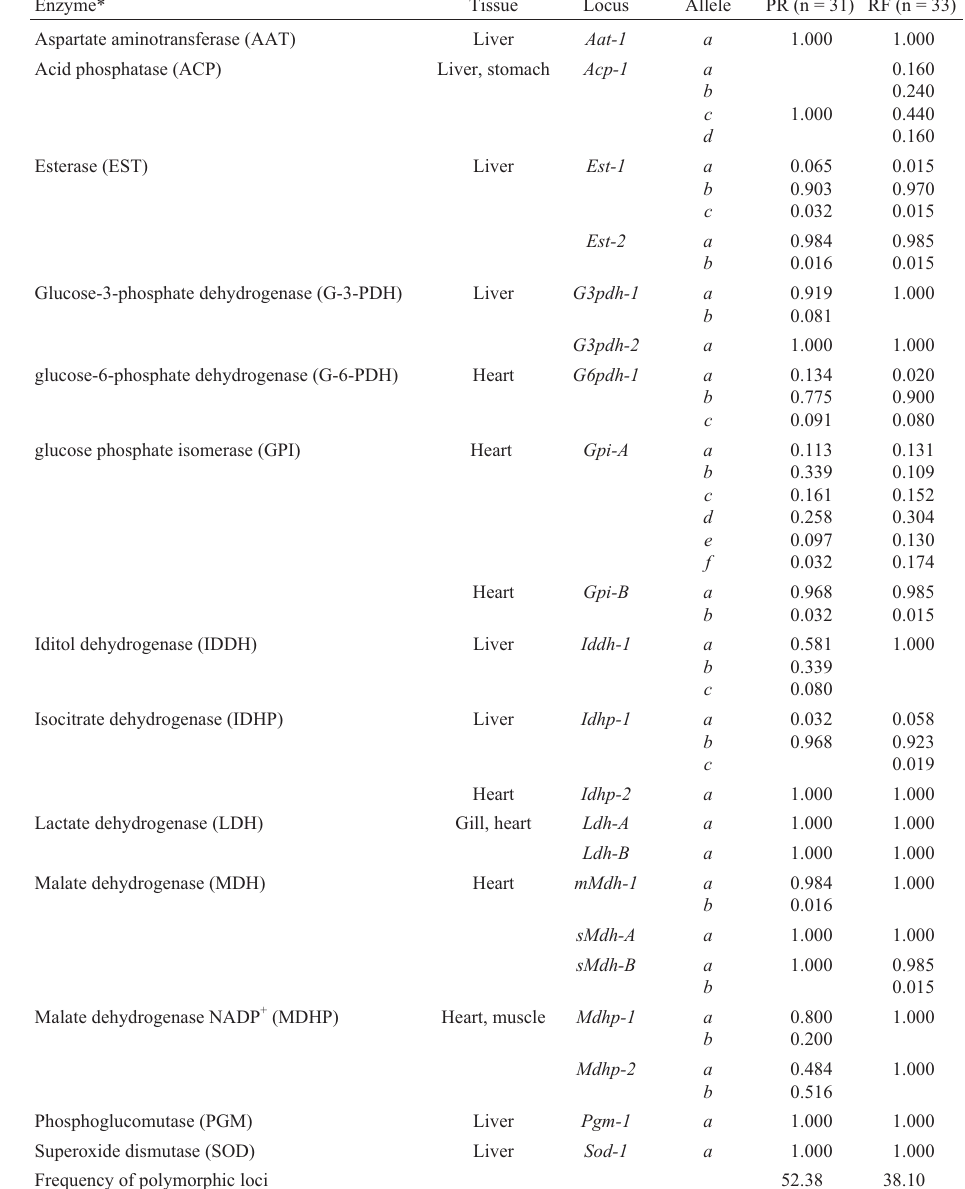
Table 1 - Allele frequencies at 21 loci of Astyanax altiparanae from the Upper Paraná River (PR) and Ribeirão Ficha (RF). Enzyme* Tissue